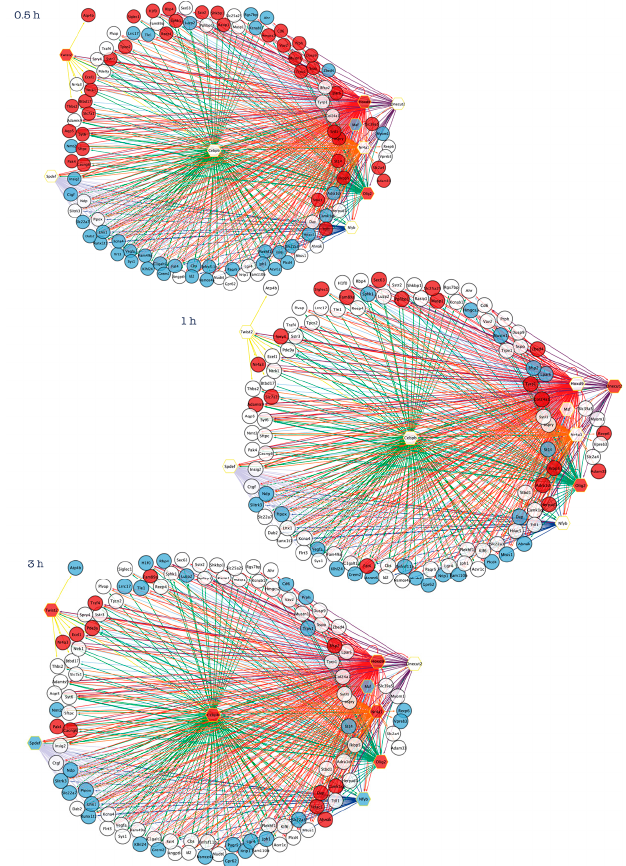
Figure 3. Reverse-engineering of transcriptional changes identifies key transcription factors at the intersection of neuronal apoptosis and survival. Inferring transcriptional gene regulatory networks of core set genes identify nine transcription factors ( Hoxd9 , Maf , Nr4a1 , Cebpb , Olig2 , Onecut2 , Spdef , Twist2 , Nfyb ), which may act as upstream regulators of neuronal cell fate [43]. Transcription regulatory network analysis generated at each time point (0.5 h, 1 h, 3 h) following induction of apoptosis or rescue by NFs emphasizes how temporally distinct apoptosis and survival-inducing signals are orchestrated by the action of interconnected and temporally ordered TFs. Regulatory networks are visualized by Cytoscape and for each time-point the node color is consistent with the expression logFC of each gene: genes in blue are down-regulated by NFs treatment, while genes in red are up- regulated. Transcription factors are represented as hexagon nodes, while gene targets are represented as circle nodes. Regulons for each transcription factor are represented by different edge